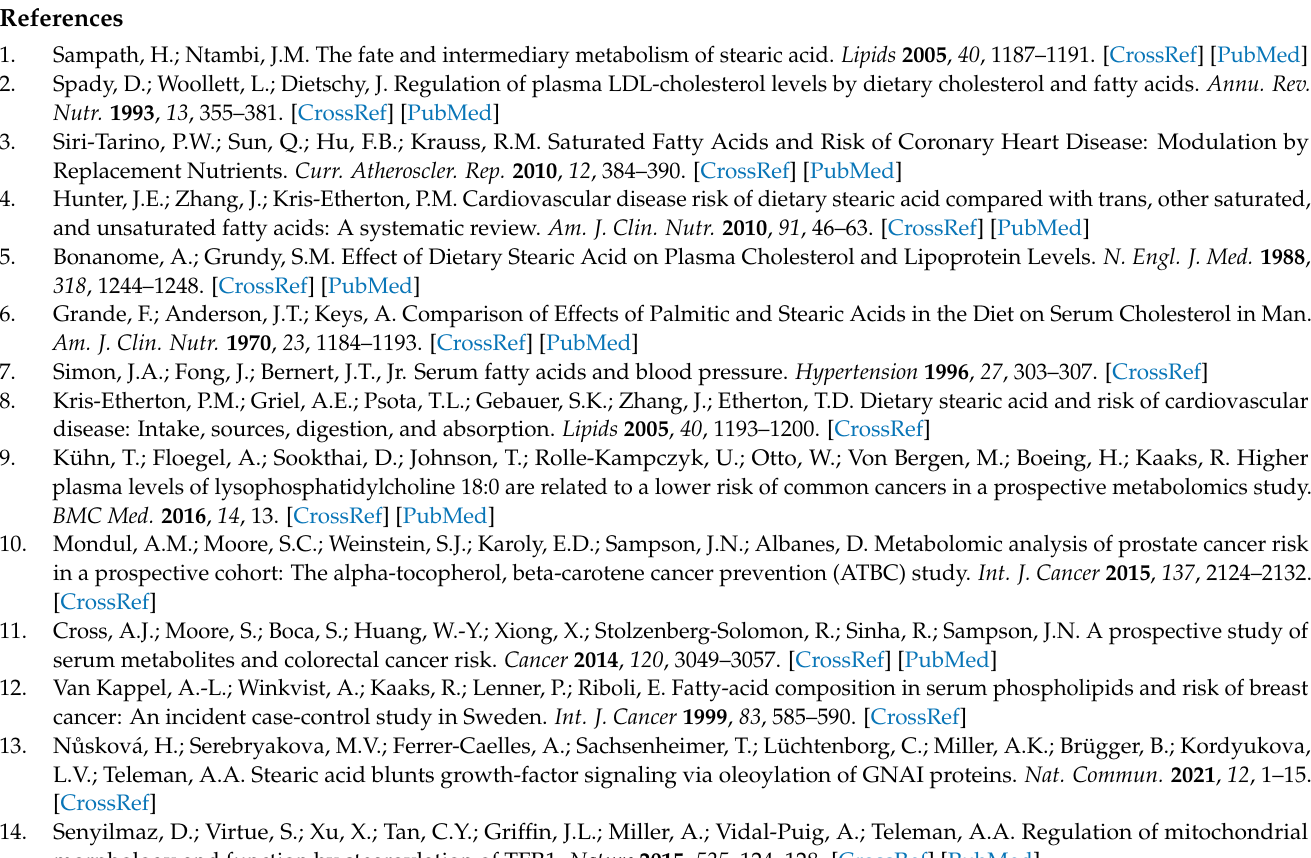
Figure S1: GO-BP (Biological Process) enrichment analysis for DEGs; Figure S2: GO-CC (Cellular Component) enrichment analysis for DEGs. Supplementary File S4: Correlation analysis of the results of RNA-seq and qPCR for detected